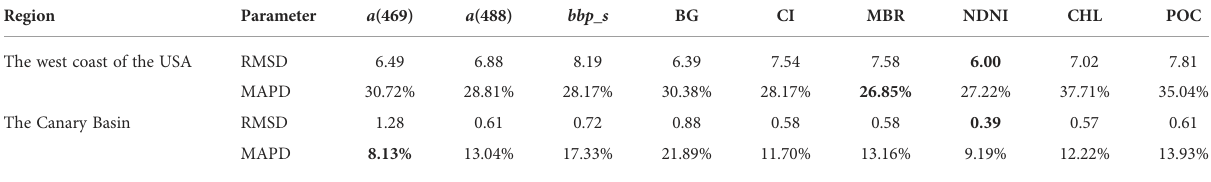
TABLE 5 Statistics of model performance for the west coast of the United States and the Canary Basin. Region